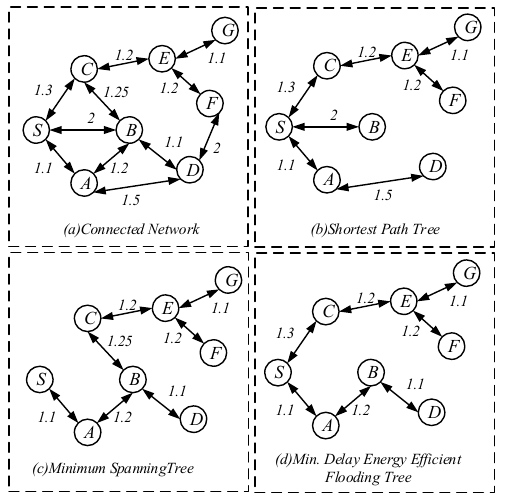
Figure 2. 3 different code dissemination strategy diagrams.